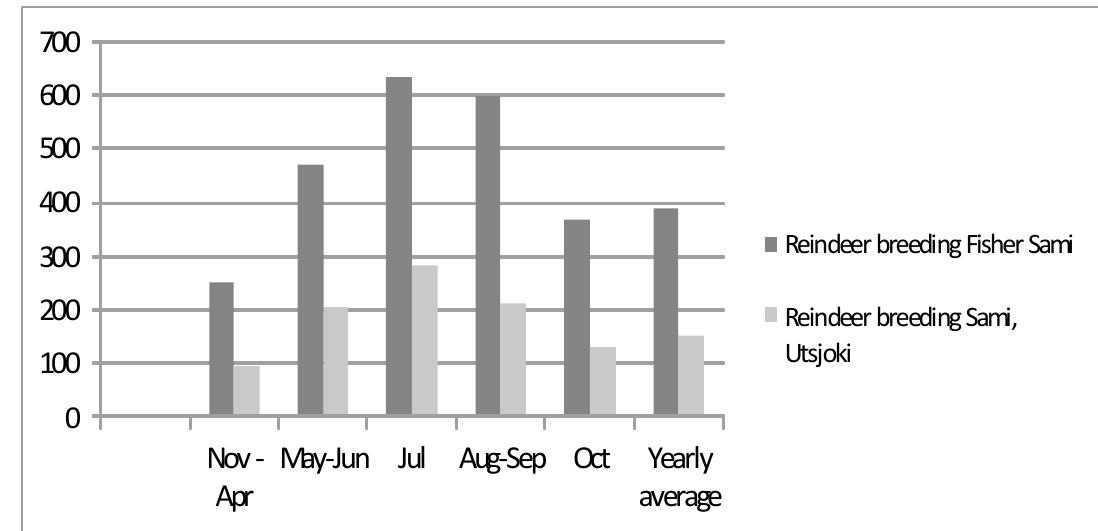
Figure 5. Consumption of fish (grams per person per day) by reindeer-herding Sami men in Utsjoki and reindeer-herding Fisher Sami men in Inari in the 1960s in different months in the individual survey [25].